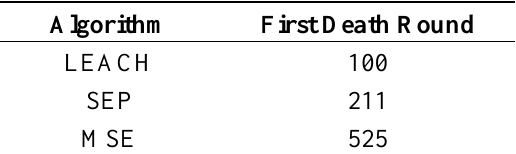
Table 2. Round when first node